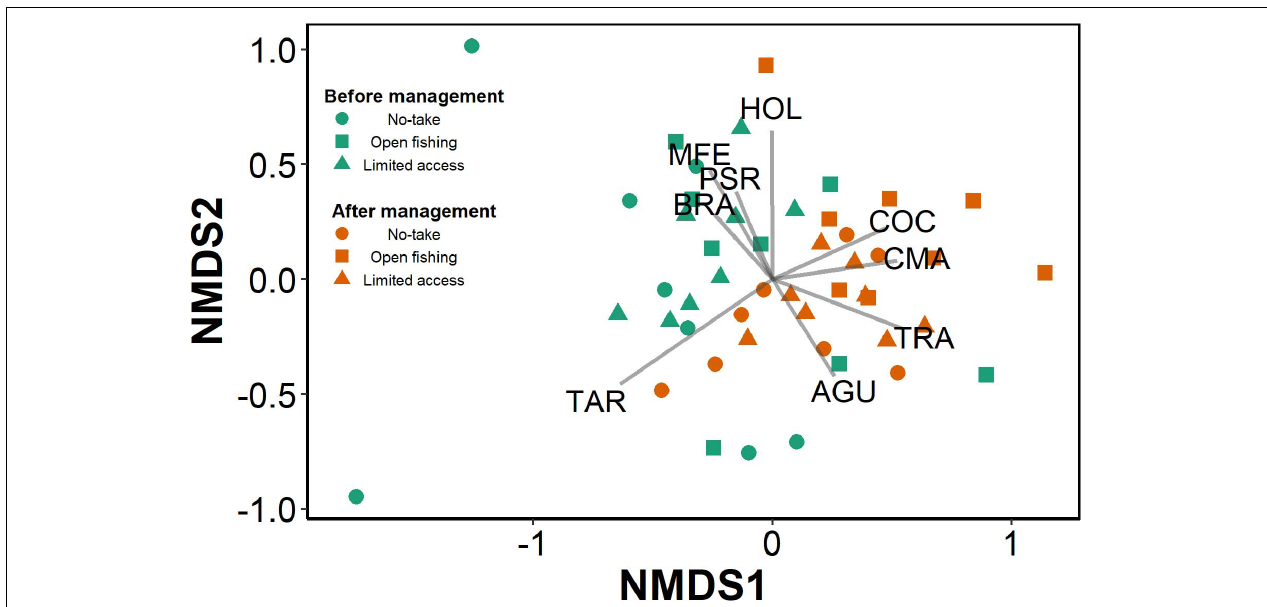
FIGURE 4 | Non-metric multidimensional scaling (axes nMDS1 vs. nMDS2) plot where the green points represent the sampling events completed performed before co-management implementation and orange represent the sampling events completed after co-management implementation. Circles represent samplings in no-take lakes, triangles represent samplings in limited access lakes, and squares in open to fishing lakes. BRA, Brycon amazonicus ; PSR, Psectrogaster rutiloides ; MFE, Mesonauta festivum ; AGU, Ageneiosus ucayalensis ; TRA, Triportheus albus ; TAR, Tetragnopterus argenteus ; CMA, Calophysus macropterus ; COC, Curimata ocellata